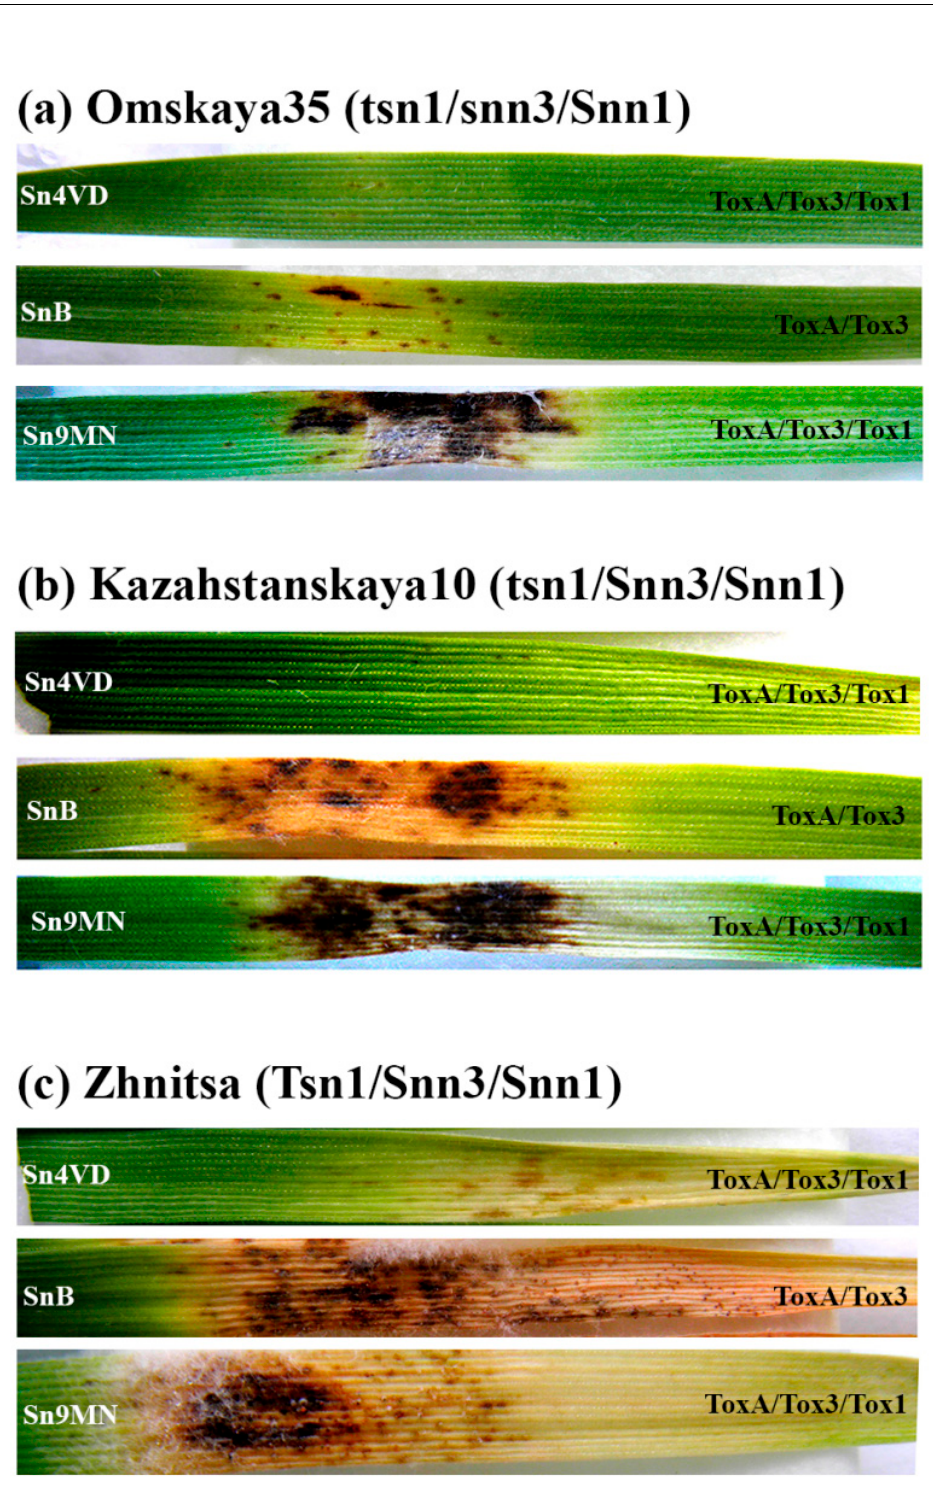
Figure 3. Analysis of phenotypes of gene-for-gene interactions in various compatible and incom- patible combinations in the S. nodorum – T. aestivum pathosystem. Photographs represent results of a typical variant from a series of experiments. Experiments were carried out on the separated first leaves. The development of symptoms was recorded 6 days after infection of three bread spring wheat varieties with different allelic states of susceptibility genes Omskaya 35 ( tsn1/snn3/Snn1 ) ( a ), Kazakhstanskaya 10 ( tsn1/Snn3/Snn1 ) ( b ) and Zhnitsa ( Tsn1/Snn3/Snn1 ) ( c ) with three isolates of S. nodorum SnB, Sn9MN, Sn4VD carrying a different set of NE genes SnToxA , SnTox3 and SnTox1